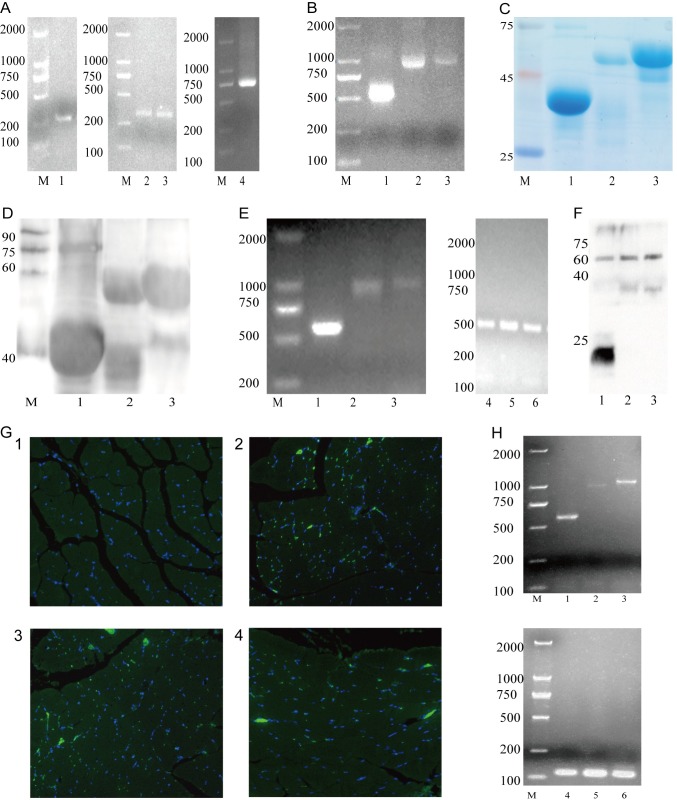
Detecting the target gene and its expression in prokaryotes and eukaryotes.(A) Prior genes were amplified by PCR. Lane M: DNA marker (DL2000), lane 1: a-linker (258bp), lane 2: k-linker (322bp) and lane 3: linker-k (322bp) and lane 4: linker-g (714bp). (B) B: Double combined genes were amplified by overlap PCR. Lane M: DNA marker (DL2000), lane 1: a-k (504bp), lane 2: a-g (897bp) and lane 3: k-g (963bp). (C, D) SDS-PAGE and Western blot of prokaryotic expression. Lane M: protein marker, lane 1: purified multi-epitopes protein pAmastin-Kmp-11 (39.8KDa), lane 2: purified multi-epitopes protein pAmastin-Gp63 (52.13KDa) and lane 3: purified multi-epitopes protein pKmp-11-Gp63 (55.93KDa). (E) Double combined genes in NIH3T3 cells were amplified by Rt-PCR. Lane M: DNA marker (DL2000), lane 1: a-k (585bp), lane 2: a-g (978bp), lane 3: k-g (1041bp) and lane 4–6: Rt-PCR amplification of GAPDH from three groups above, respectively. (F) Western blot of eukaryotic recombinant plasmid expression in NIH3T3. Lane 1: pVAX1-a-k (20.8KDa), lane 2: pVAX1-a-g (36.13KDa) and lane 3: pVAX1-k-g (37.2KDa). (G) Immunofluorescence of eukaryotic recombinant plasmids expression in BALB/c mice hind leg quadriceps. (1): G2, PBS injection. (2): G3, pVAX1-a-k injection. (3): G4, pVAX1-a-g injection. (4): G5, pVAX1-k-g injection. (H) Double combined genes in BALB/c mice hind leg quadriceps were amplified by RT-PCR. M: DNA marker (DL2000), lane 1: a-k (585bp), lane 2: a-g (978bp), lane 3: k-g (1041bp) and lane 4–6: RT-PCR amplification of GAPDH from three groups above, respectively.